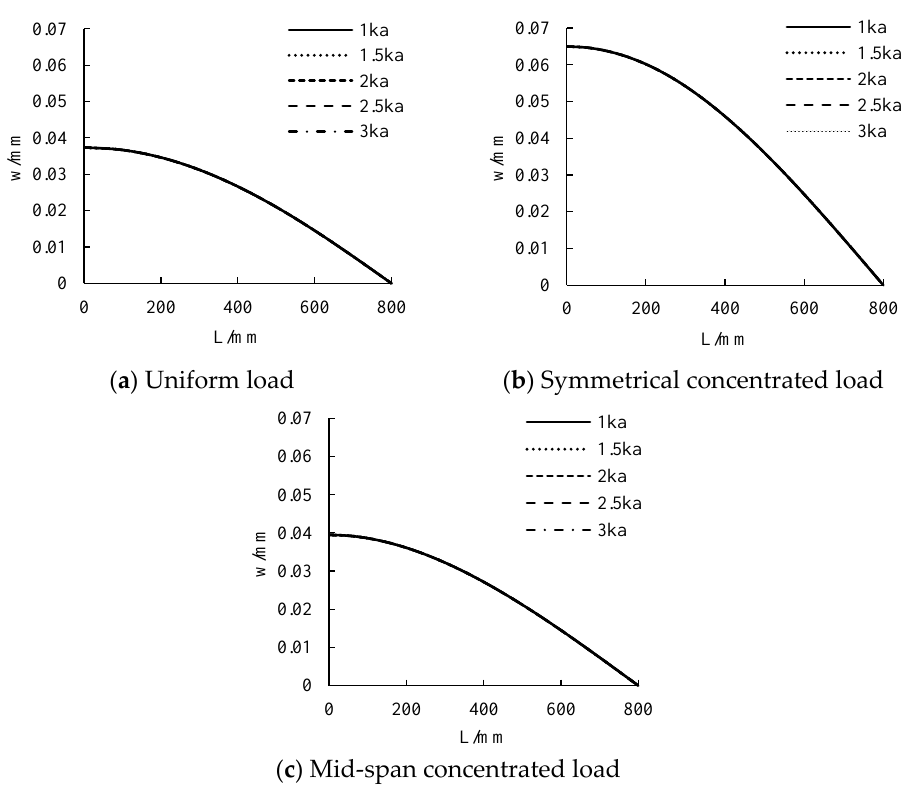
Figure 13. The influence of adhesive layer stiffness on displacement.